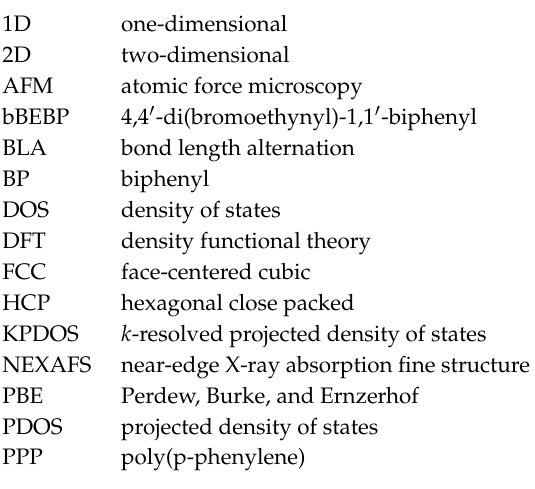
Figure S2: (a) Structural model and inequivalent carbon atoms in bBEBP/Au(111) embedding a Au adatom (red) in between two organic units. (b) Decomposition of the corresponding NEXAFS spectrum into the individual initial-state contributions, as numbered in panel (a), Figure S3: Decomposition of the NEXAFS spectrum of bBEBP/Au(111) embedding a Au adatom on contributions by the sp 2 biphenyl part (BP) and the sp 1 chains (C 2 ). (a) Spectrum averaged over the polarizations. (b) In-plane electric field along the polymer axis x and (c) orthogonal to it, y ; (d) out-of-plane electric field, z . See Figure S2a for the definition of x , y , z axes, Figure S4: NEXAFS spectrum of cumulenes (left) and polyynes (right) computed with a 20-atom and 40-atom simulation supercell. One atom per cell is excited. Polarization directions are taken with x along the chain axis and y , z orthogonal to